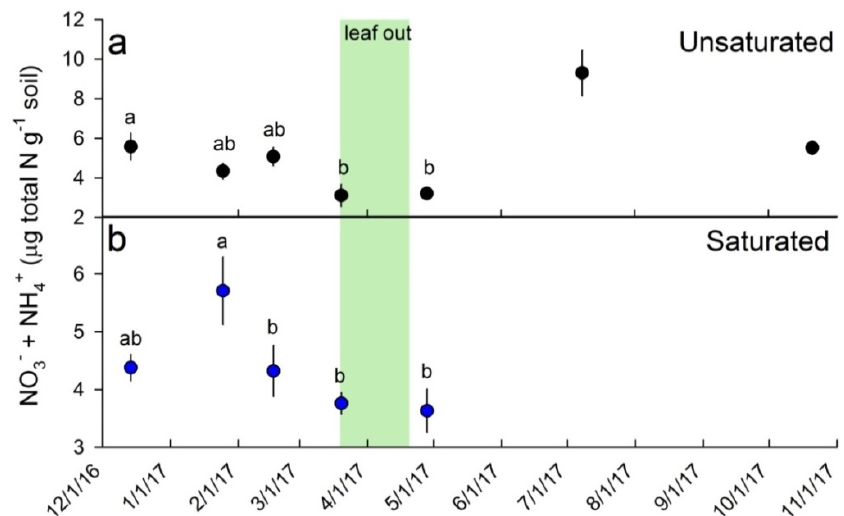
Figure 6. Monthly dormant season total nitrate–NO 3 − and ammonium–NH 4 + ( µ g total N g − 1 soil) in ( a ) unsaturated (black circles) and ( b ) saturated (blue circles) soil samples. Di ff erent letters in each soil category across dormant season months denote significant di ff erences at P < 0.05. The green box denotes when budbreak and leaf out of overstory trees occurred at the site.